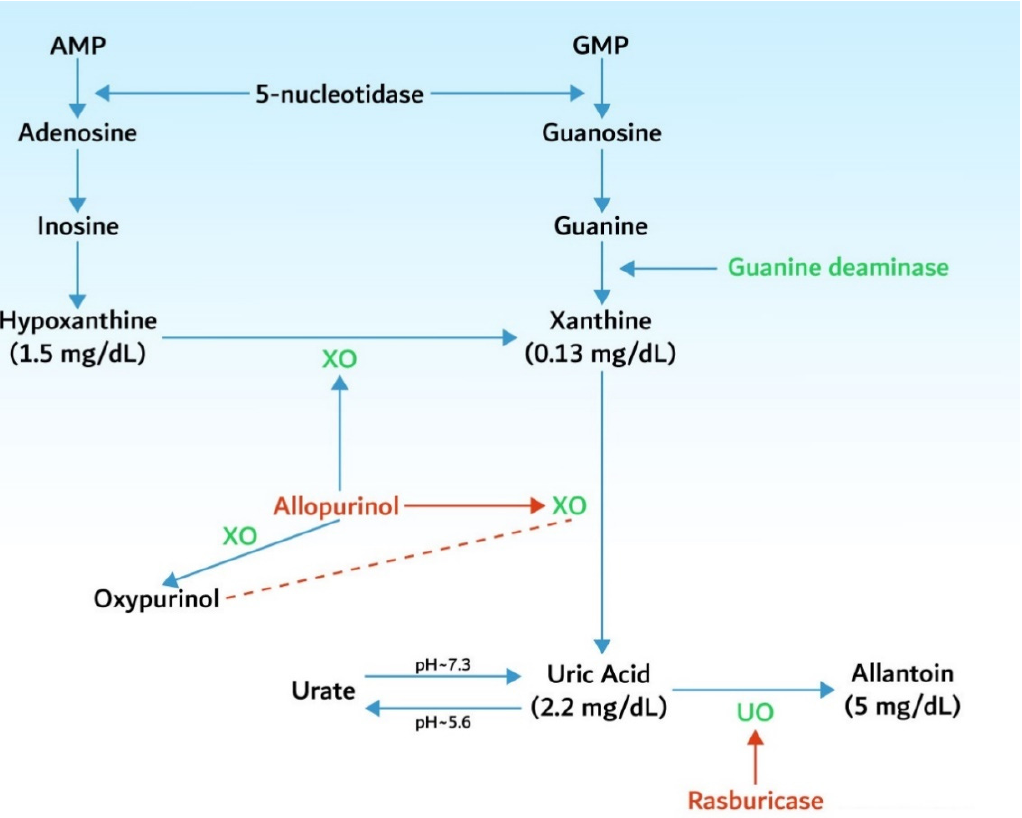
Figure 2. Uric acid metabolism and mechanisms of action of hypouricemic drugs. AMP—adenosine monophosphate; GMP—guanosine monophosphate; XO—xanthine oxydase; UO—urate oxydase.